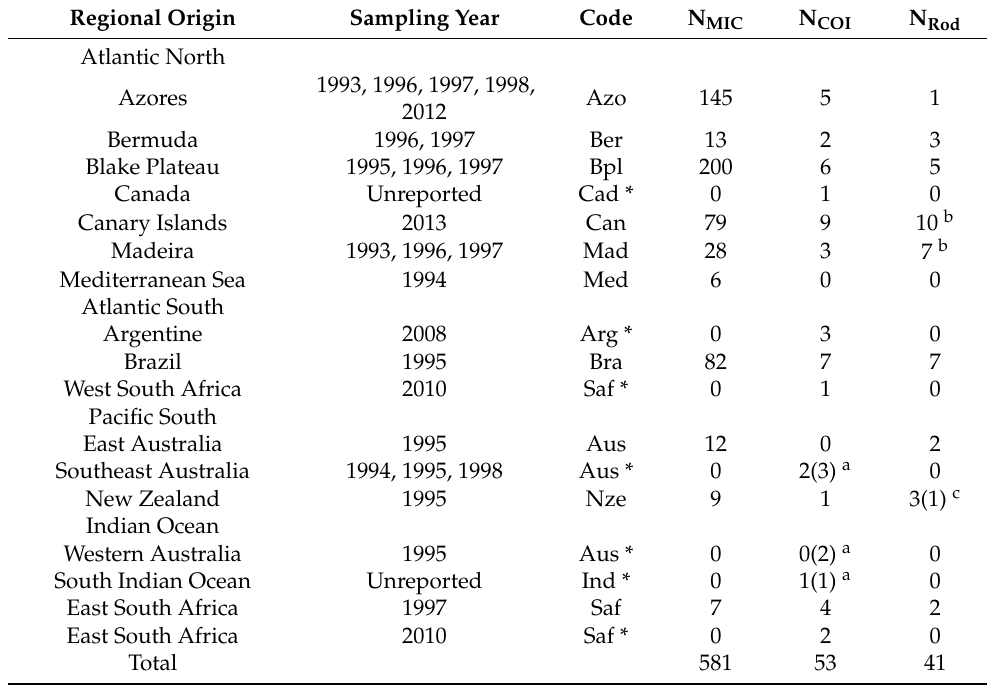
Table 1. Characteristics of samples from P. americanus analyzed in this study (see Figure 1 for sample location). Code, regional code for sample locations; N MIC , number of individuals genotyped with microsatellites; N COI , number of individuals with information for the Cytochrome Oxidase I sequence (COI); N Rod , number of individuals with information for the Rhodopsin gene sequence